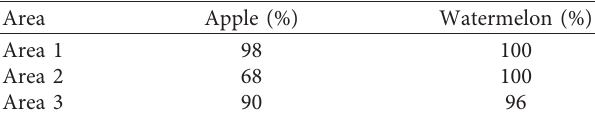
Table 4: Success rate statistics of grab.